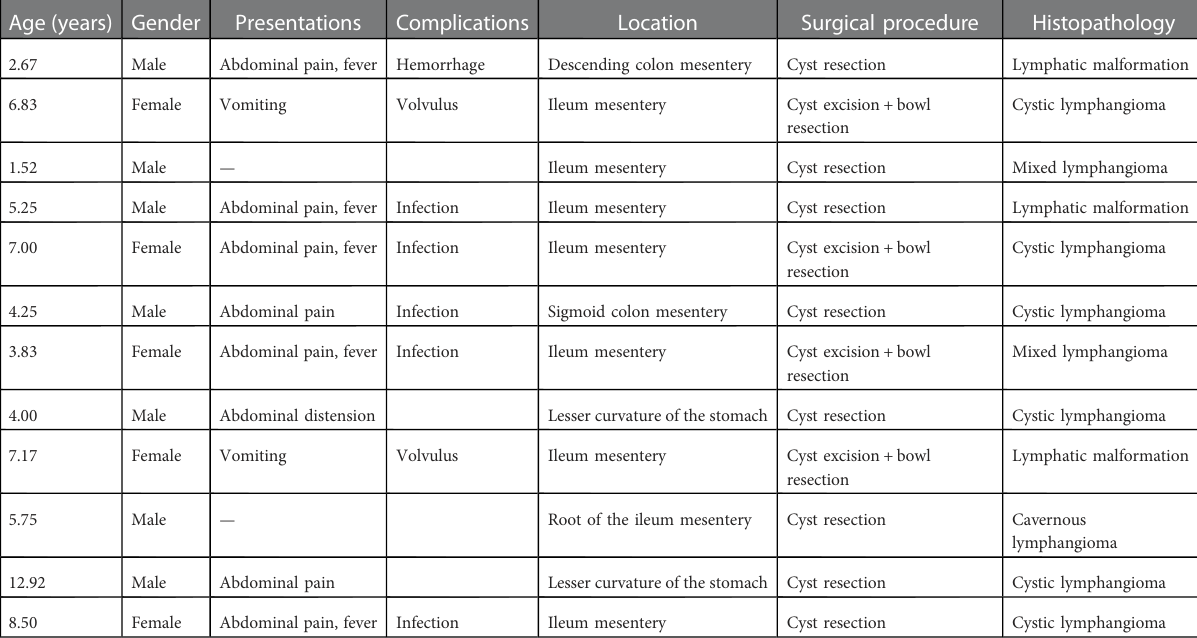
TABLE 1 Detail clinical data of mesenteric cysts in